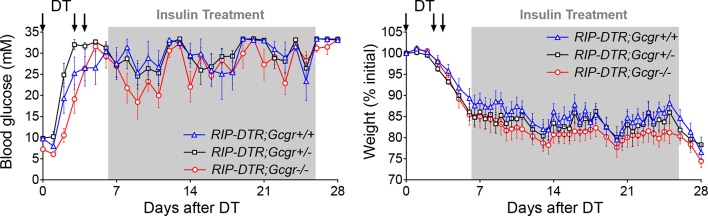
Insulin administration stabilizes body weight and allows survival of DT-treated Gcgr-/-mice.Glycemia (left) and body weight (right) of RIP-DTR;Gcgr+/+ (blue triangles, N=7), RIP-DTR;Gcgr+/- (black squares, N=9), and RIP-DTR;Gcgr-/- (red circles, N=9) males following DT-mediated β-cell ablation and exogenous insulin treatment. Grey areas indicate the period during which mice were treated with insulin detemir (5 U/kg/day between days 6 and 25).